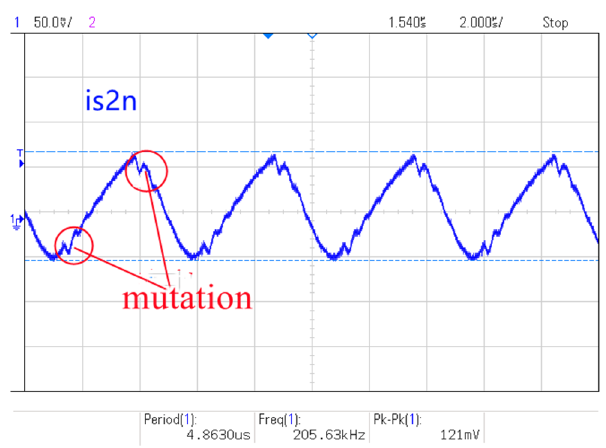
Figure 23. Traditional topology static .